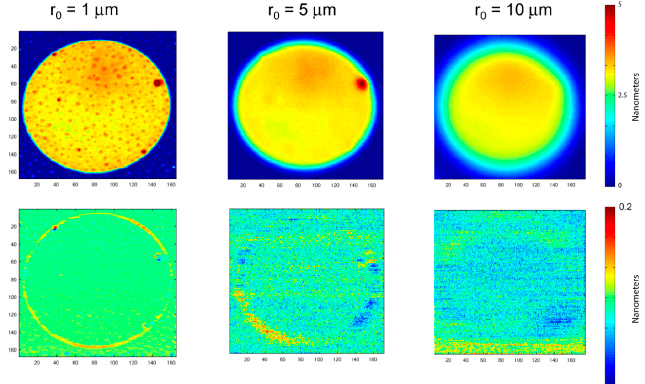
Figure 5. Top row: Scans at different beam radii. Color bar has a maximum at 5 nm. Bottom row: The difference of two consecutive scans (without dismount) showing edge effects and noise. Color bar on the bottom has a maximum at 0.2 nm.